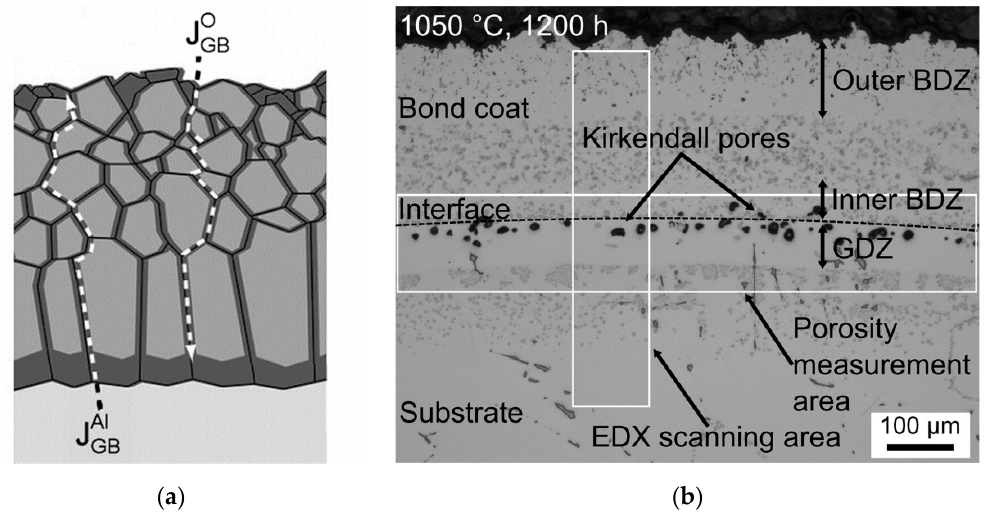
Figure 10. ( a ) The diffusion paths of O and Al atoms during the TGO growth [82]; ( b ) the interdiffusion of alloy element between BC and substrate [83].